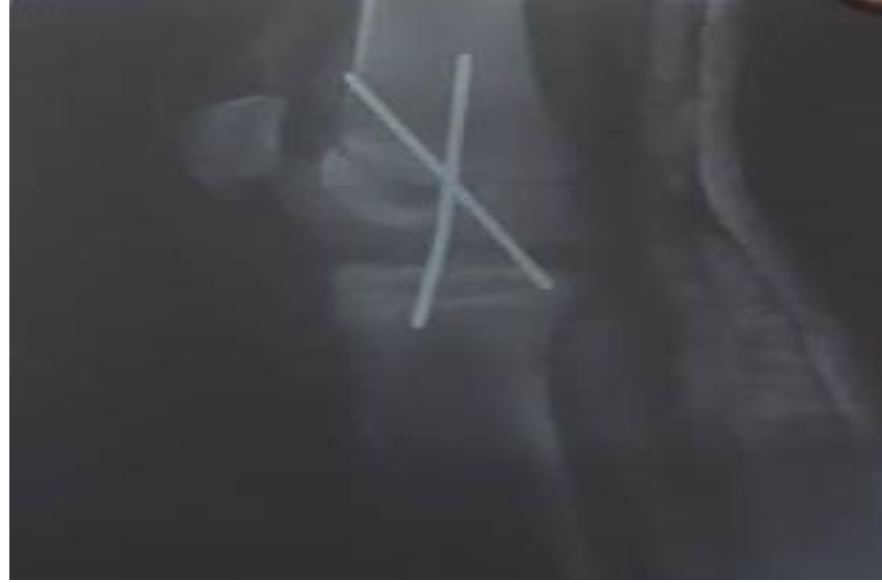
Figure 2. Plain X-ray of the left knee with percutaneous cross-pins for bone stabilization. A prescription of prophylactic antibiotics with IV cefazolin, 1 g every 6 h, and pain medications (NSAIDs) was given, after which the patient was discharged home with cephalexin 500 mg tablets to be taken by mouth (PO) every 12 h for two weeks. Four weeks later, there was no improvement, and the patient returned to the hospital with fever and pain in the left knee not controlled with NSAIDs. A plain radiograph was performed, which revealed osteomyelitis of the distal left femur as shown in Figure 3.